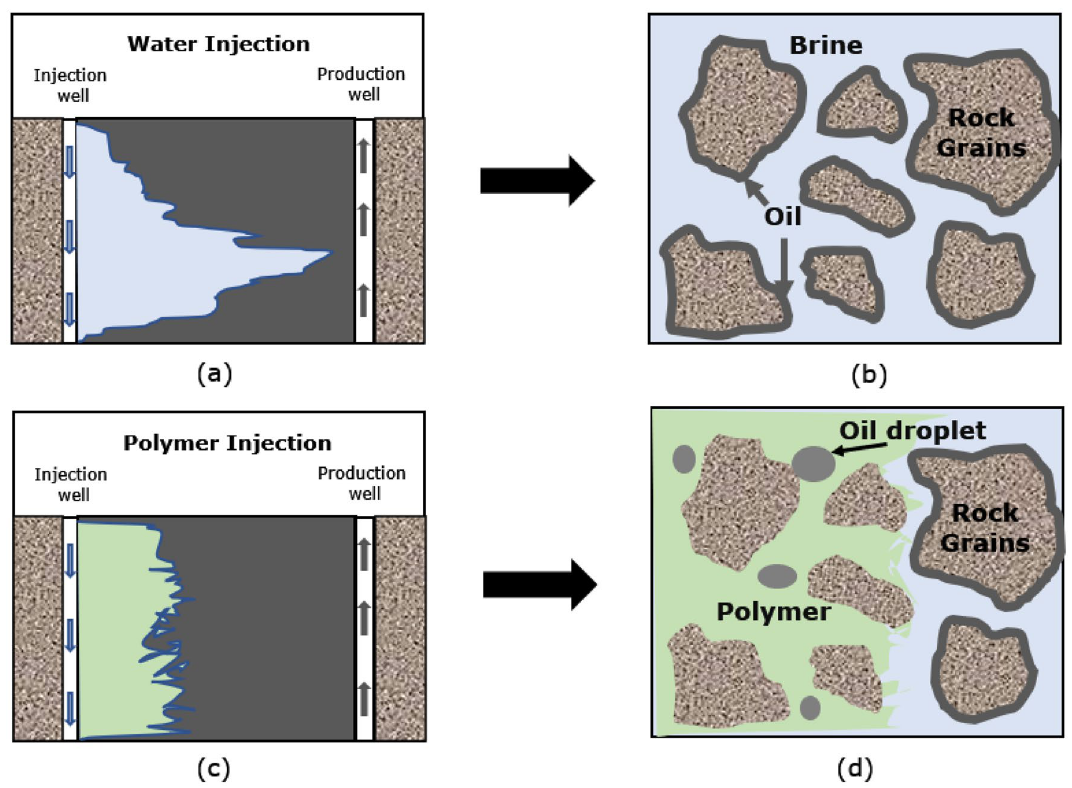
Fig. 1 Application of EOR techniques demonstrating mobility control and wettability alteration: a waterflood operation with viscous finger- ing, b oil-wet wettability condition, c polymer flood operation with a stable front and d water-wet wettability